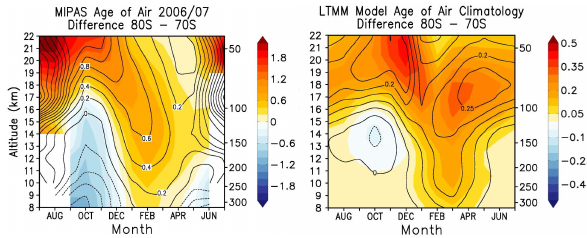
Figure 10: MIPAS observed (left) and UMUKCA modelled (right) time-height cross sections of age-of-air differences between 80°S and 70°S. For MIPAS the year 2006/7 is shown in isolines and the climatology is shaded. For UMUKCA pair A is shown (shaded: experiment with PSCs; isolines: experiment without PSCs). The scales for age gradients are different to highlight the patterns (e.g. sign reversal). Note that the meridional gradient is stronger for the MIPAS observed case: For MIPAS the orange shading indicates an age difference above 0.6 years, for the model the same colour indicates an age difference around 0.2 years. Positive differences are shown in warm colours and negative in cold colours.